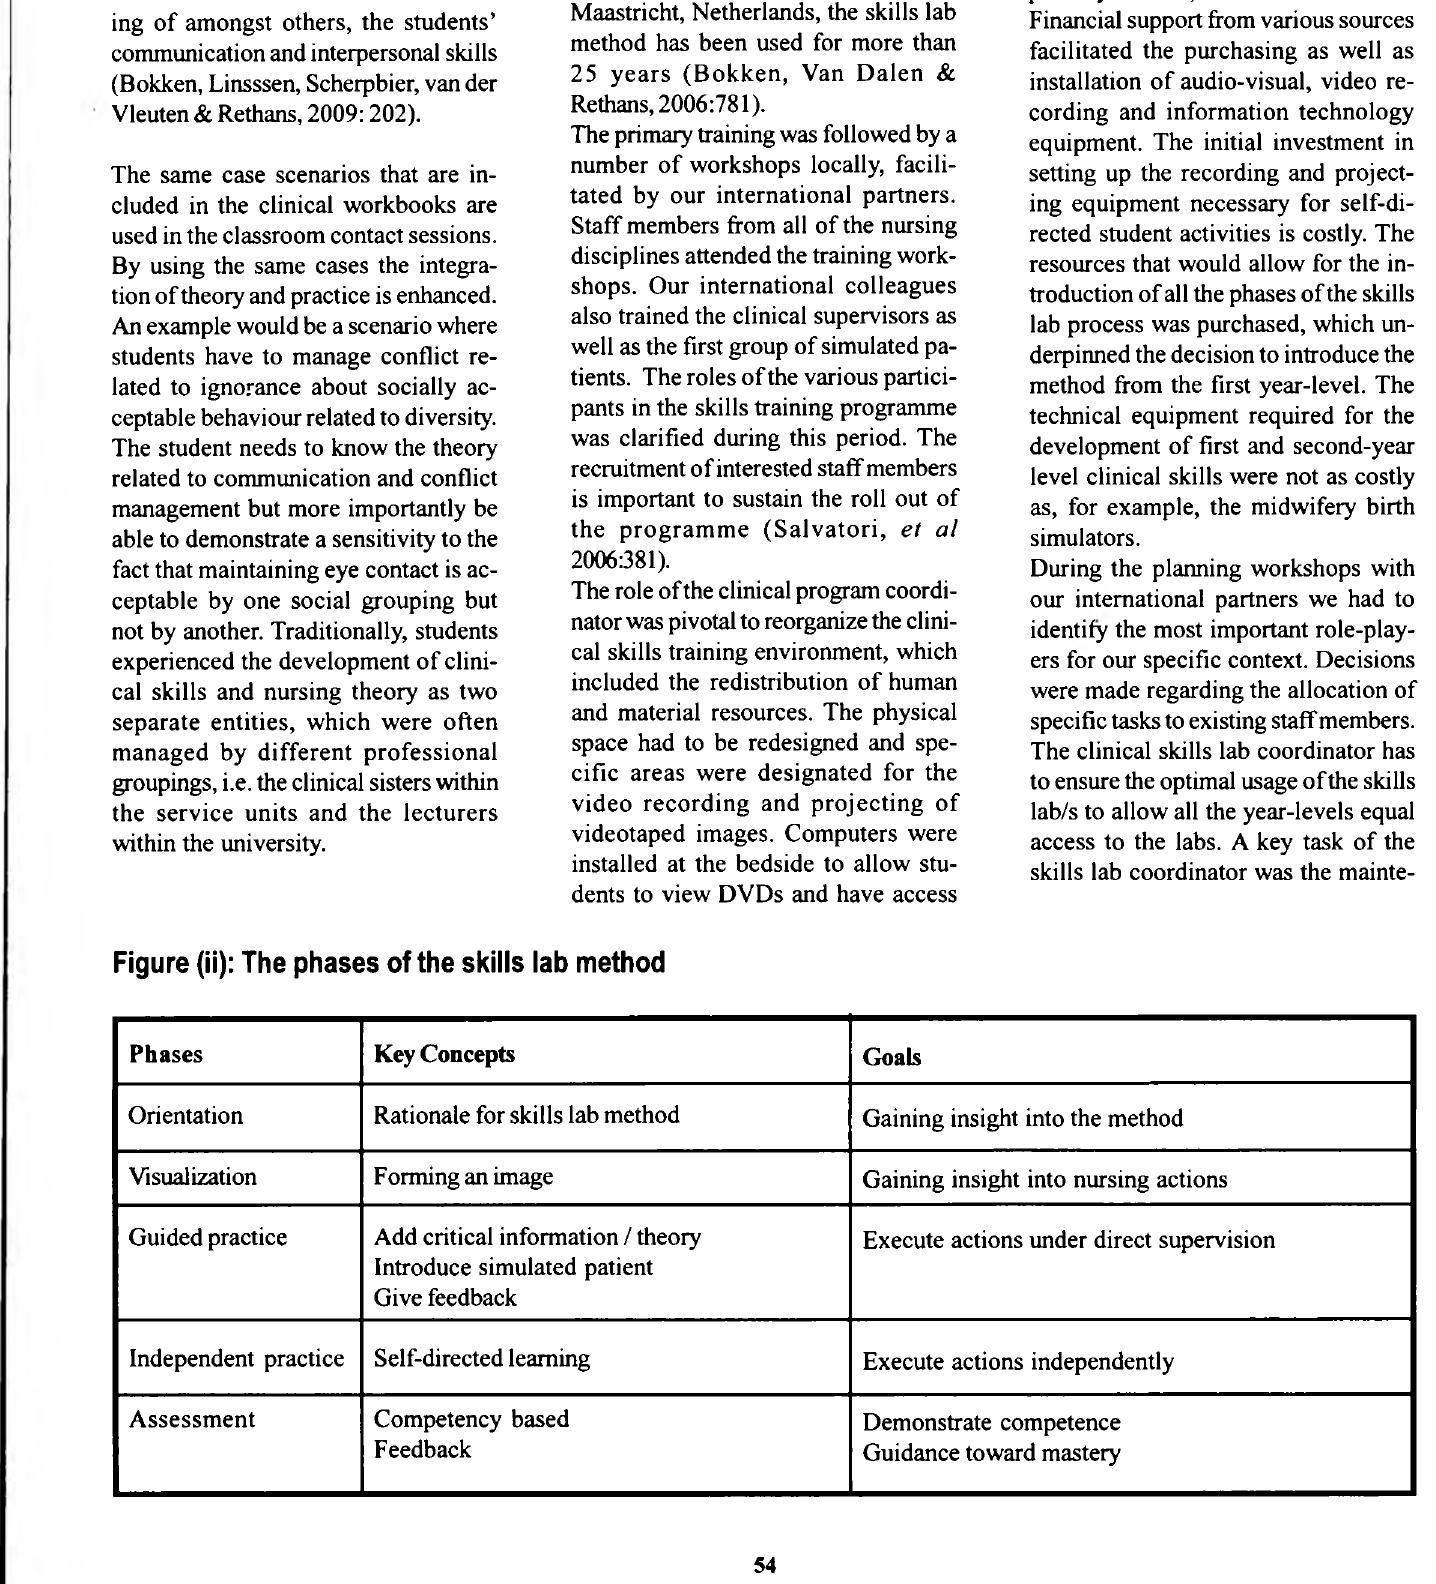
Figure (ii): The phases of the skills lab